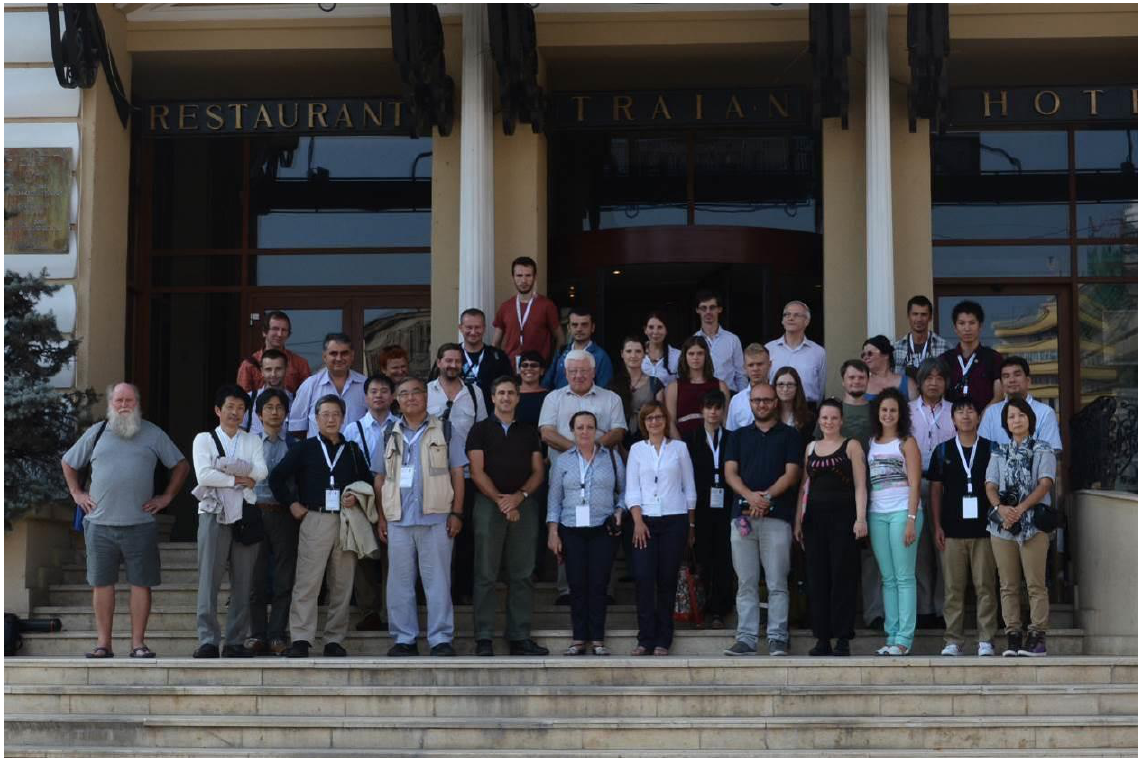
Figure 1. “Stories Written in Stone” International Symposium on Chert and other Knappable Materials. Symposium. (Photo by Bogdana